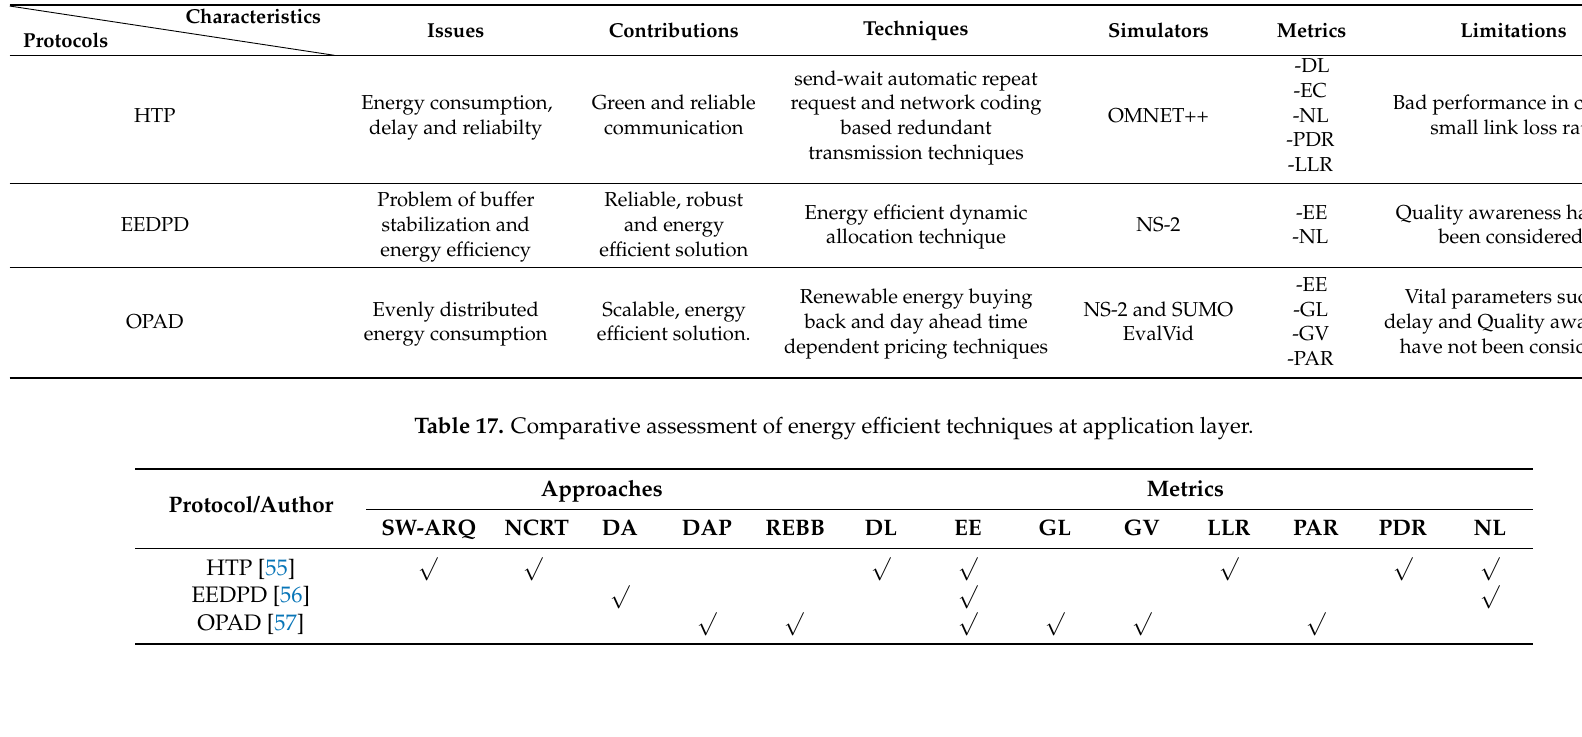
Table 16. Summary of energy efficient techniques at application layer.